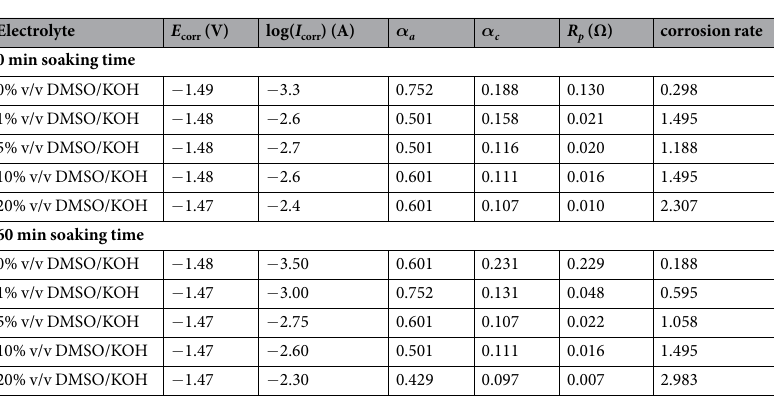
Table 1. Parameters of Tafel analysis for the zinc anode in electrolytes containing DMSO from (0 to 20)%